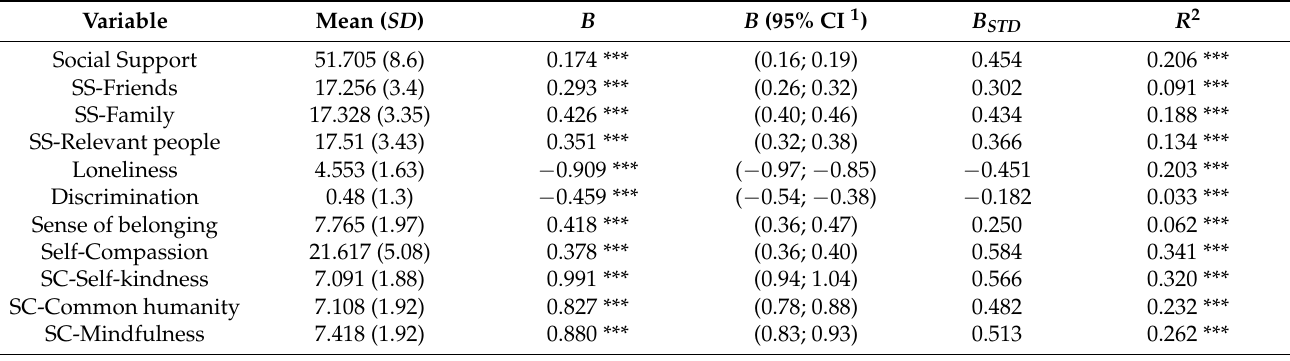
Table 4. Association between psychosocial variables and peace and meaning.